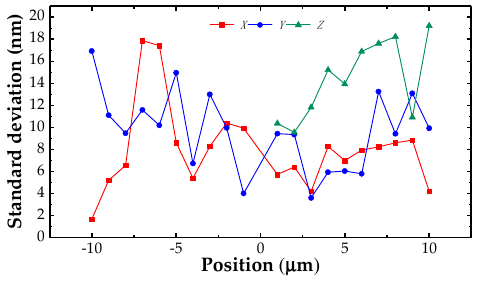
Figure 12. Results of the repeatability measurement.